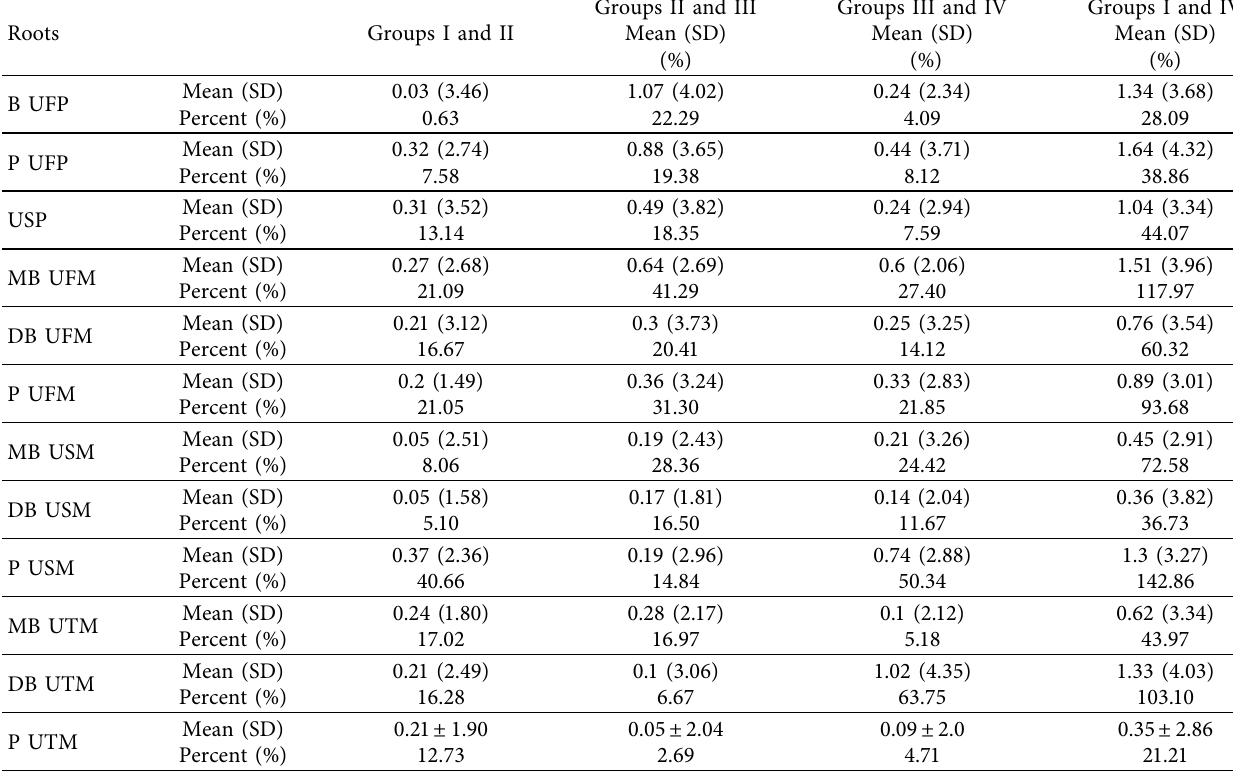
Table 3: The mean and percentage change (increase) in the distance between different maxillary posterior roots and MSF among age groups.